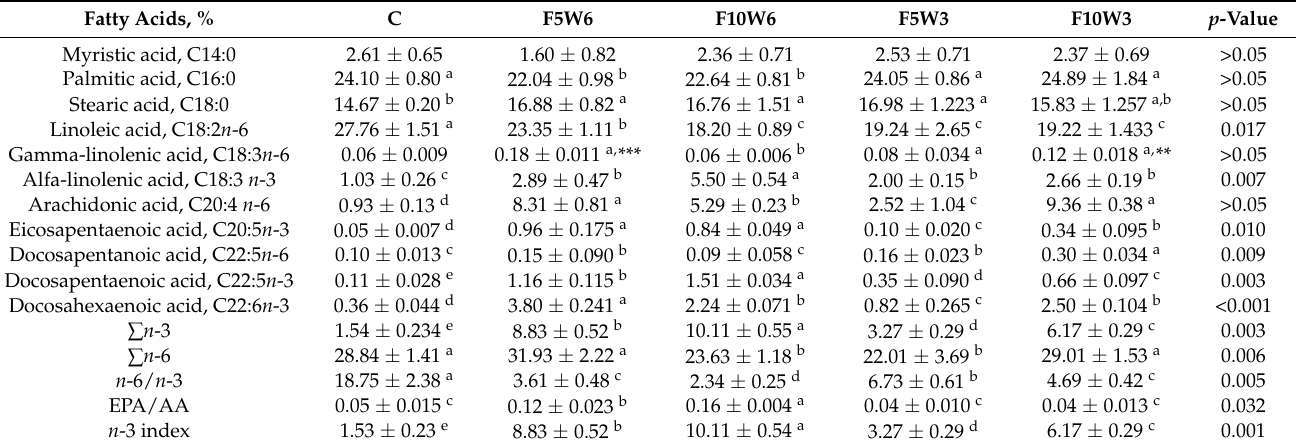
Table 7. Fatty acid composition of m. longissimus dorsi fat (means ±